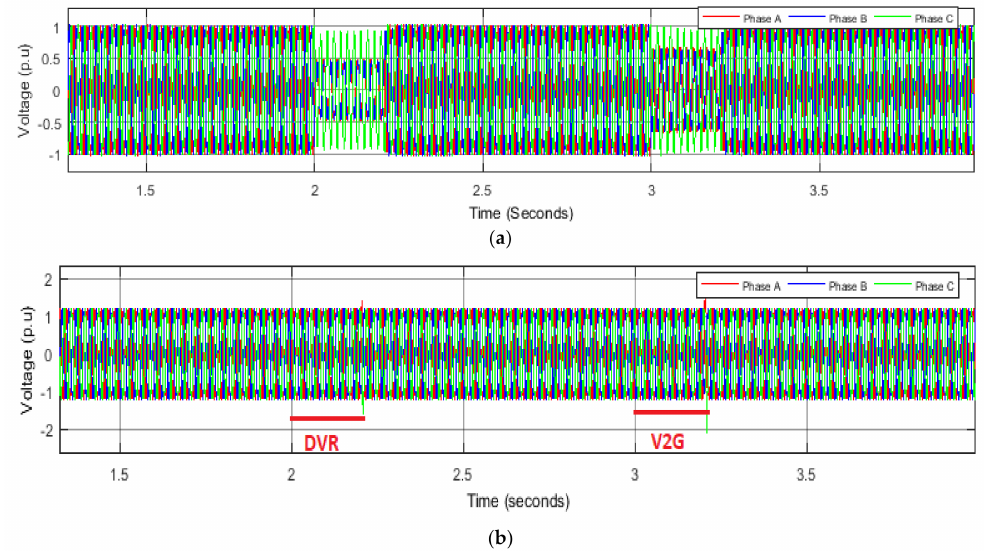
Figure 20. ( a ) Two phase symmetrical fault; ( b ) voltage compensation using DVR and V2G for two phase